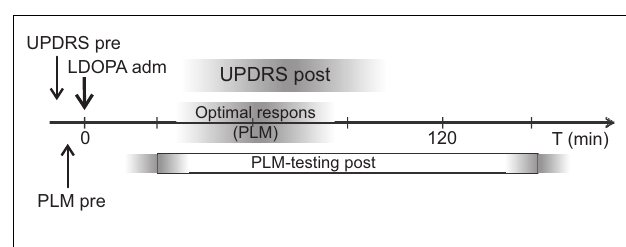
FIGURE 2 |Timeline for the L -DOPA test